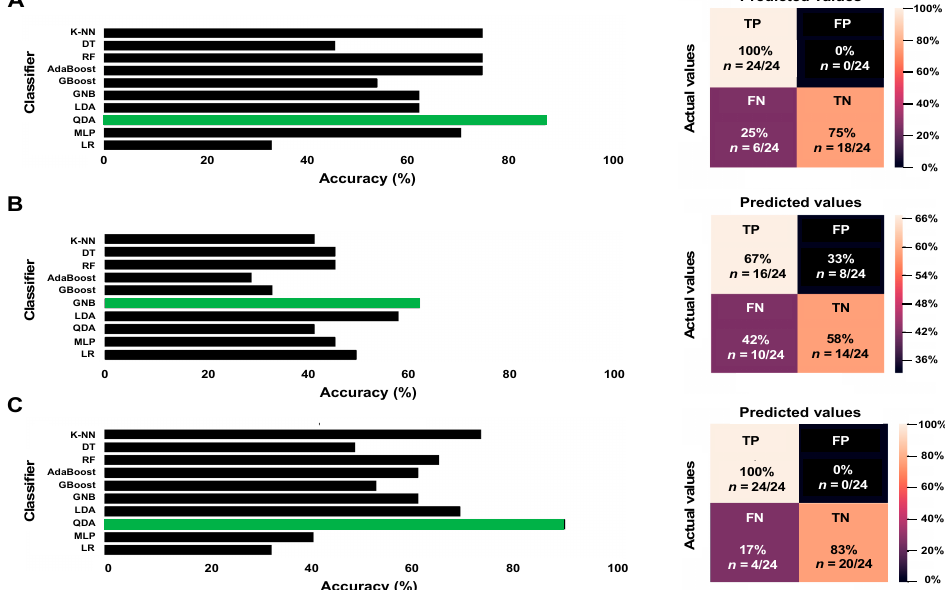
Figure 3. Accuracy values ( left ) for each of the tested classifiers and confusion matrices ( right ) corresponding to models trained with ( A ) imaging features (diffusion/perfusion MRI parameters + radiomic features), ( B ) clinical variables, and ( C ) imaging data + clinical variables. Classifiers achieving the highest accuracy values for each model are highlighted in green. AdaBoost = Adaptive Boosting; DT = Decision Tree; FN = false negative; FP = false positive; GBoost = Gradient Boosting; GNB = Gaussian Naive Bayes; K-NN = K-Nearest Neighbour; LDA = Linear Discriminant Analysis; LG = Logistic Regression; MLP = Multi-Layer Perceptron; QDA = Quadratic Discriminant Analysis; TN = true negative; TP = true positive.